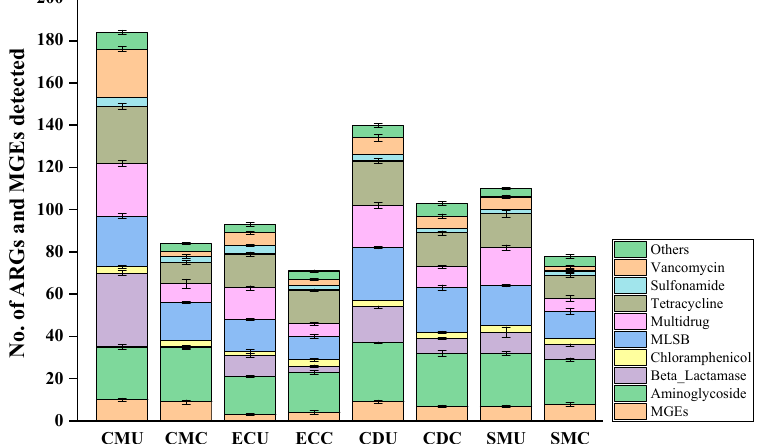
Figure 4. The detected number of antibiotic resistance genes (ARGs) and mobile genetic elements (MGEs) in the four sets of organic fertilizer samples, includes CMU and CMC, ECU and ECC, CDU and CDC, SMU and SMC. MLSB: macrolide-lincosamide-streptogramin B.